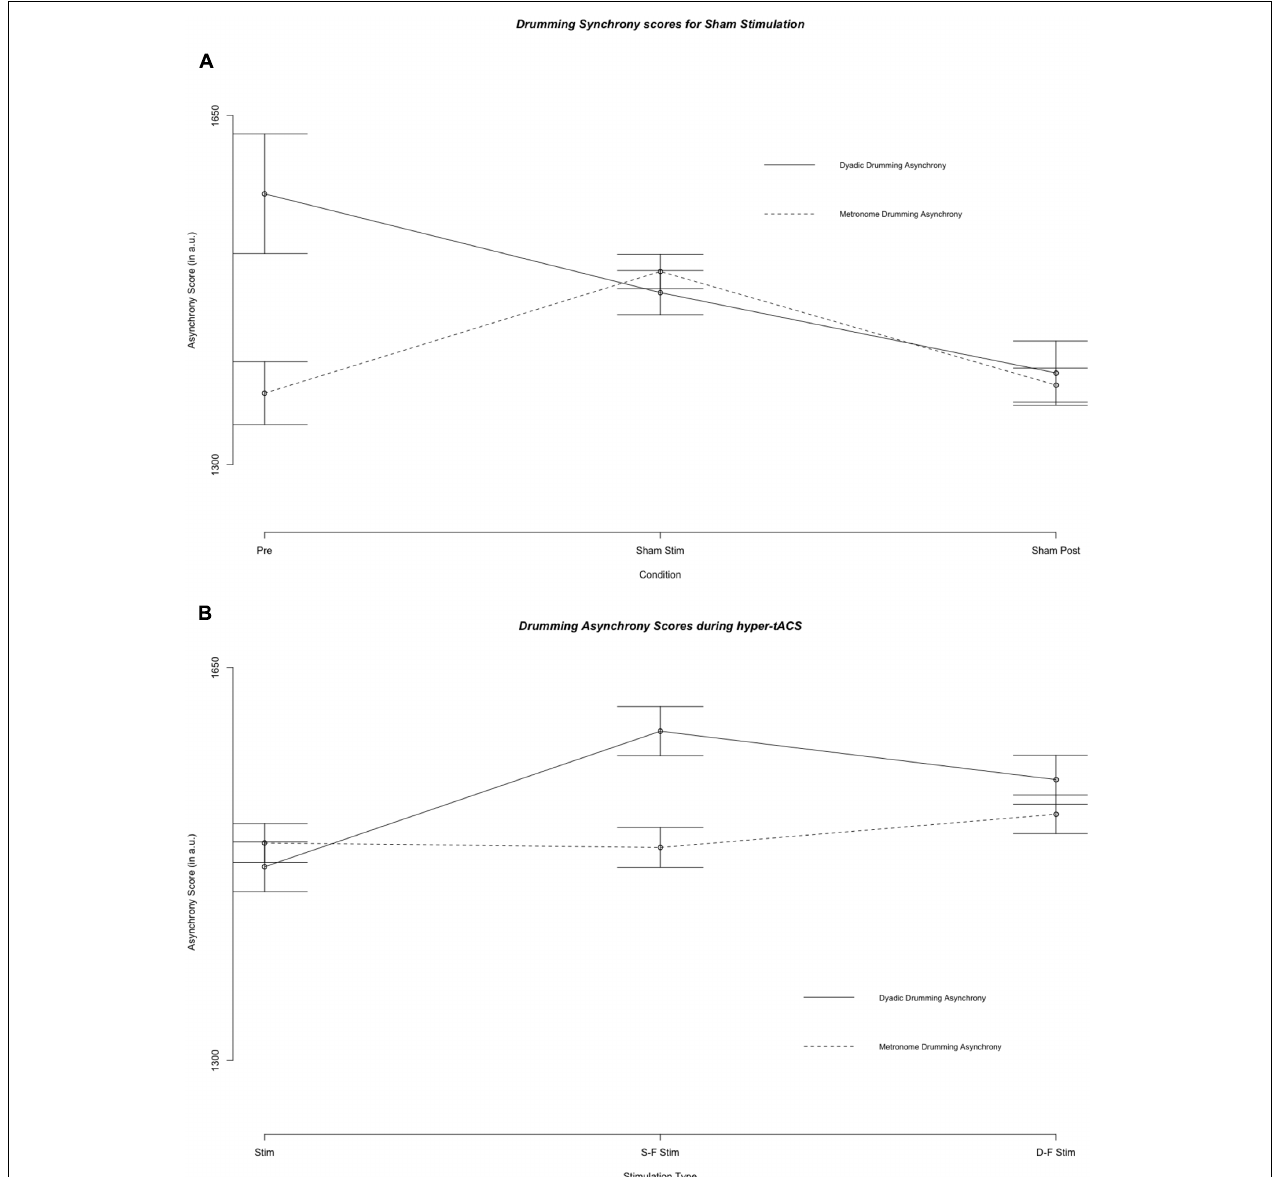
FIGURE 4 | Results of the fixed effect of the linear mixed model analysis for the effect of condition on asynchrony scores. (A) Asynchrony scores during pre stimulation (Pre), sham stimulation (S Stim) and sham post-stimulation (S Post). (B) Asynchrony scores during the three stimulation types: sham stimulation (S Stim), same-phase-same-frequency stimulation (S-F Stim) and different-phase-different-frequency stimulation (D-F Stim). Standard errors are indicated by horizontal lines.